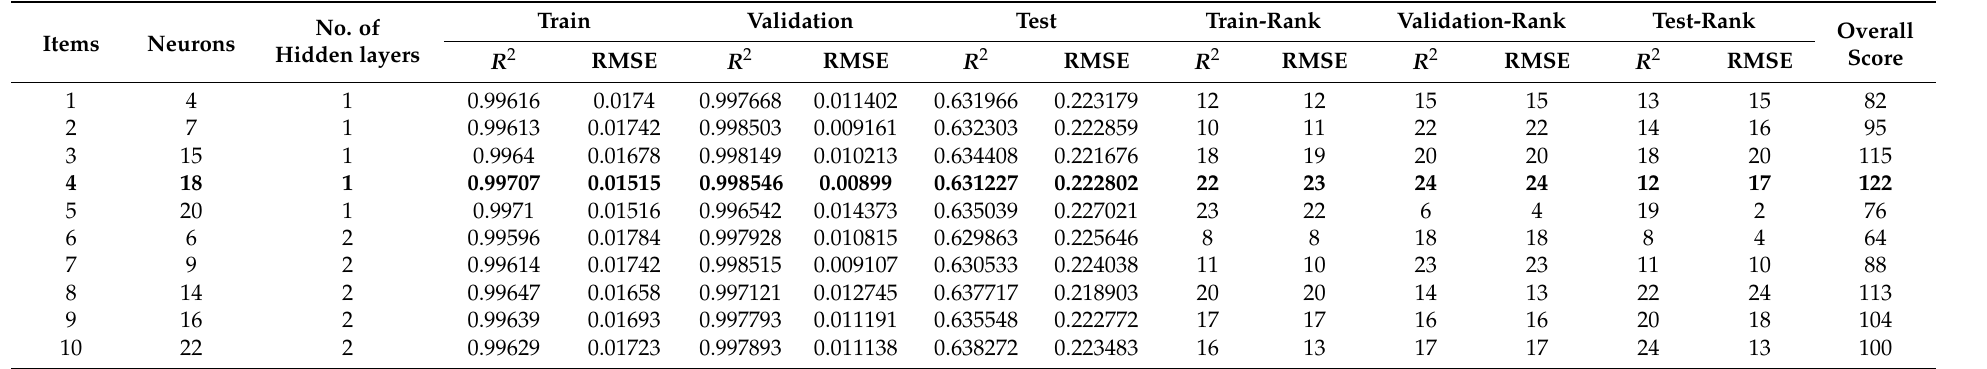
Table 6. Selecting the optimal ANN model with respect to hidden layers and neurons for the UK